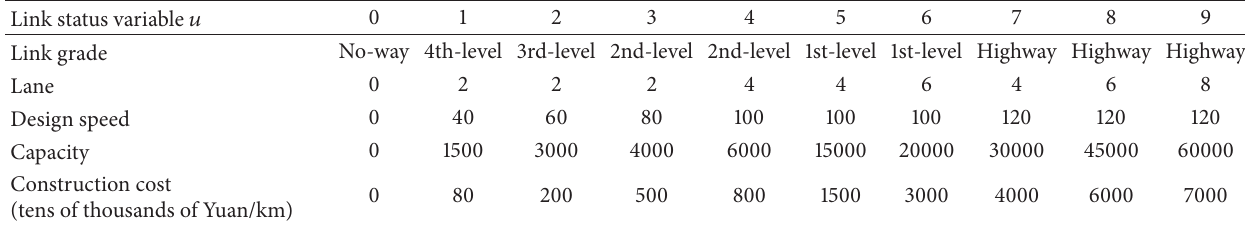
Table 1: Decision variables of link grade and its corresponding information in